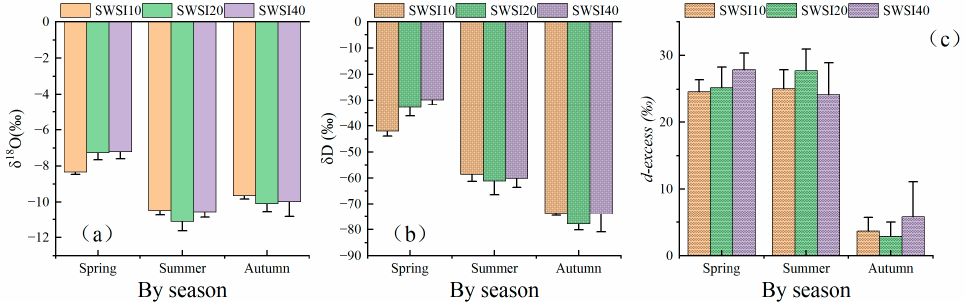
Figure 6. Seasonal variation in ( a ) ∆ d, ( b ) δ 18 O and ( c ) d-excess of soil water in different soil layers. Black line represents standard deviation.